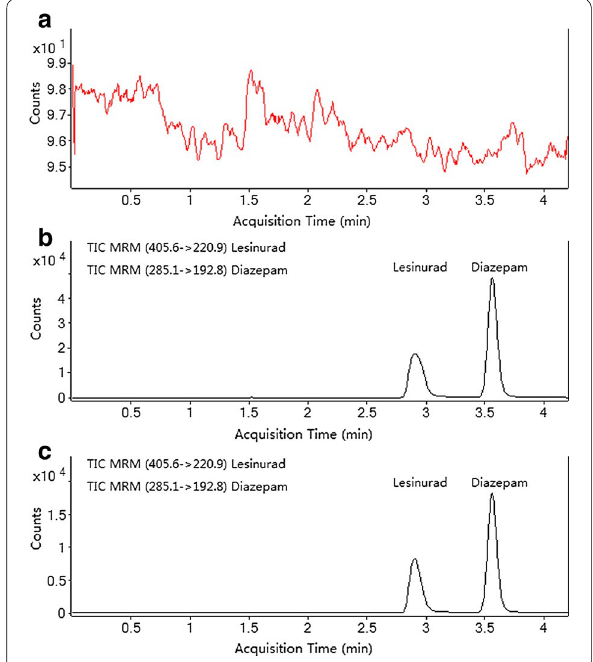
Fig. 2 Representative UHPLC–MS/MS chromatograms of lesinurad and IS in rat plasma samples. a A blank plasma sample; b a blank plasma sample spiked with lesinurad and IS; c a rat plasma sample obtained 1 h after oral administration of